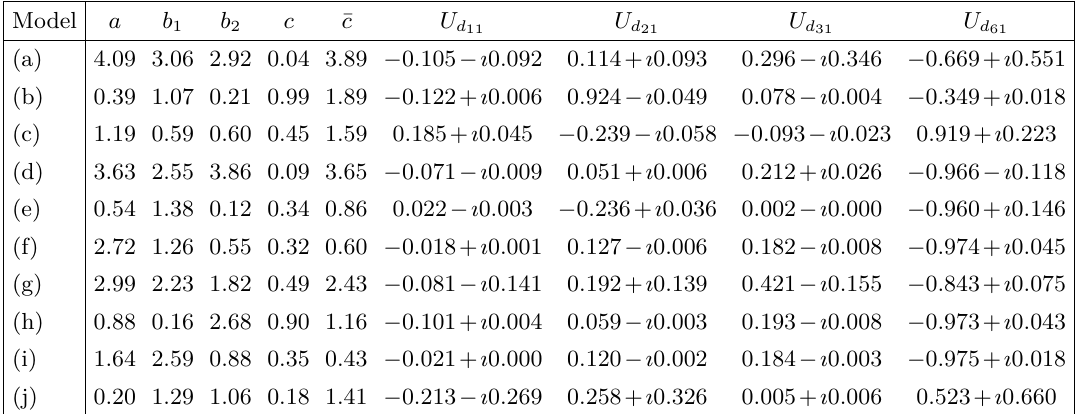
Table 2 . A numerical estimate of the elements of the down Higgs zero mode eigenvector using the analysis of table 1 and the couplings of eq.